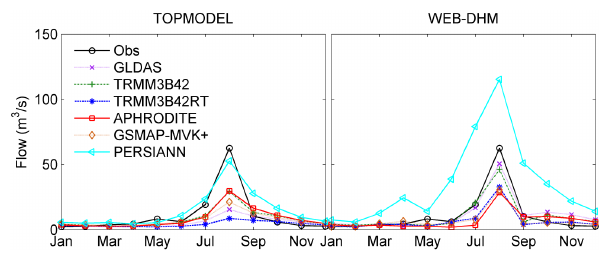
Figure 14. Inter-annual average monthly